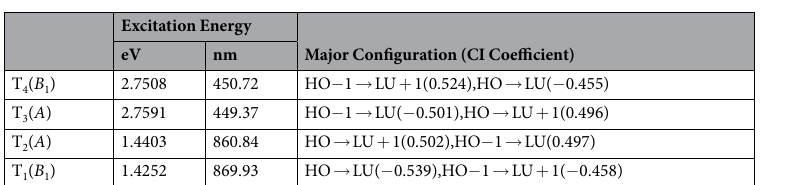
Table 1. Triplet excited states at the optimized structure for T 3